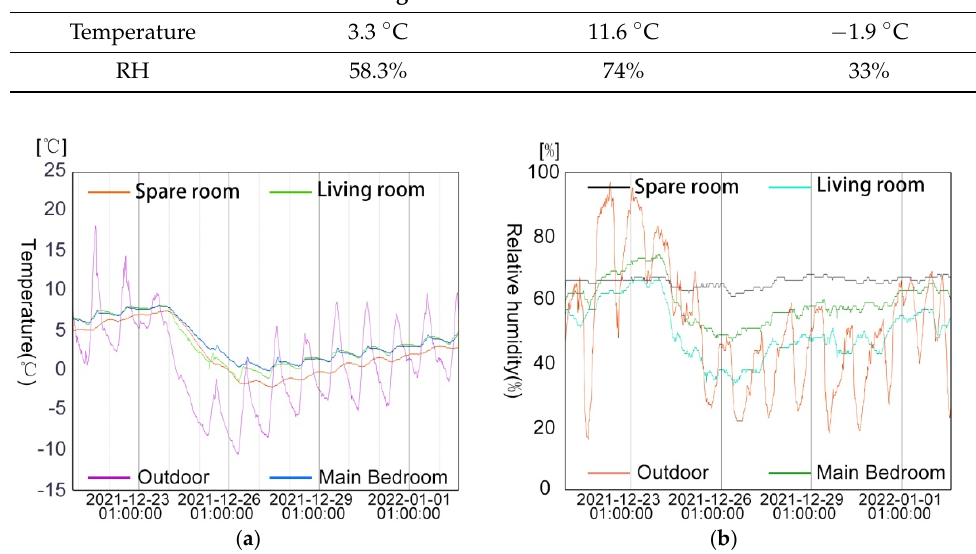
Figure 18. Distribution of indoor environmental parameters for W1: ( a ) air temperature; ( b ) relative humidity. Table 8. Statistics of indoor environmental parameters for W1.